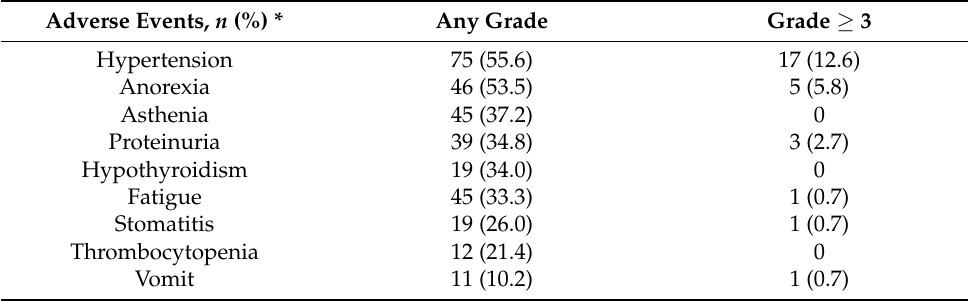
Table 3. Adverse events of Lenvatinib for ATC